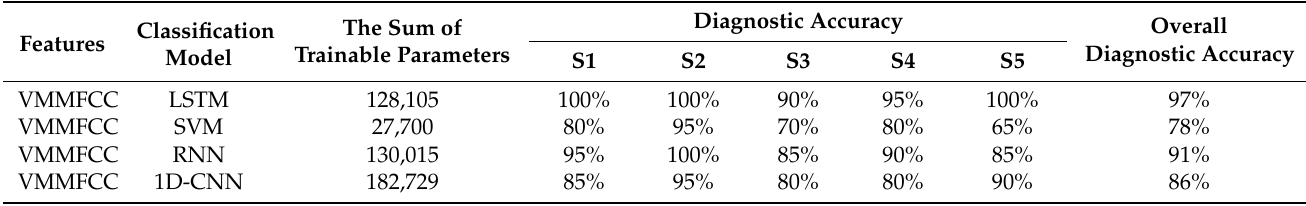
Table 10. Accuracy of different diagnostic models.